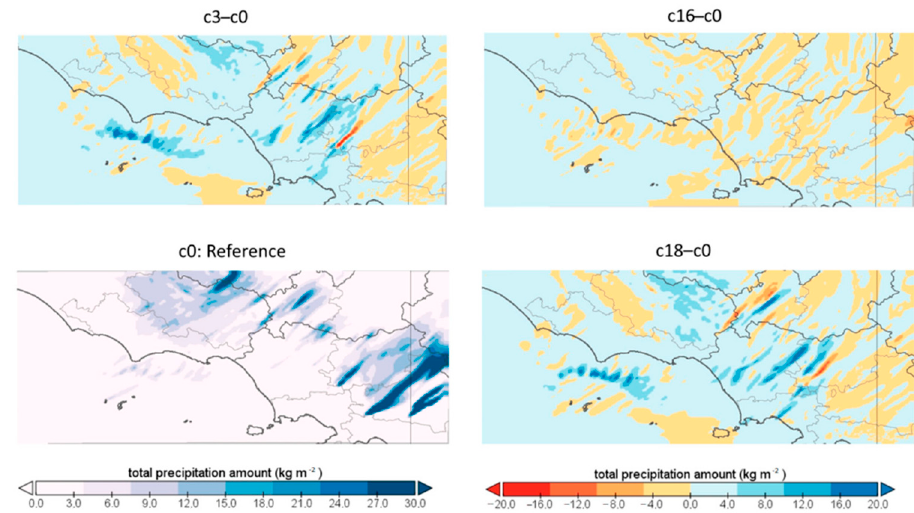
Figure 6. Precipitation maps (mm) related to 6 November 2017 for configuration c0 (reference) and di ff erence of distributions obtained with configurations c3, c16, and c18 compared to the reference